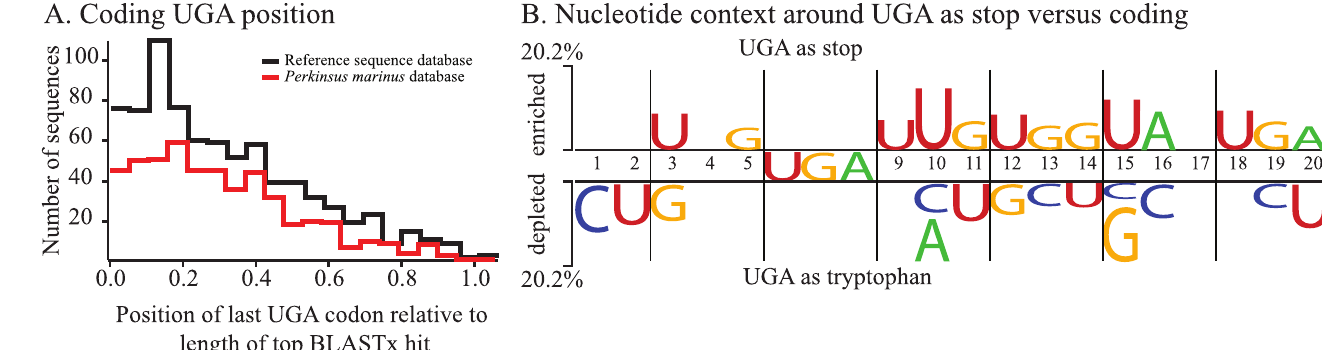
Fig 4. Position and nucleotide context around UGA codons. A. The amino acid position of the last or most 3’ UGA codon in the query sequence alignment was divided by the total length of the top hit in the BLASTx comparison and plotted as a histogram to indicate where the UGA codons were found relative to the total length of the subject sequence. Comparisons to P . marinus (red) and the reference sequence (black) databases are shown for AT biased sequences with increased BLASTx scores when using alternative genetic codes. B . The composition before and after UGA apparently encoding stop versus UGA as tryptophan, based on increased BLASTx scores when UGA was translated as tryptophan. In frame UGA as stop for 457 non-redundant sequences from the parasite fraction were compared to 333 in UGA as tryptophan using two sample logo with the t-test. The size of the nucleotide shows the relative enrichment or depletion of each nucleotide in the upstream and downstream positions, but is shown only for nucleotides enriched or depleted at a p-value below 0.05 (see S2 Fig for raw frequency values).